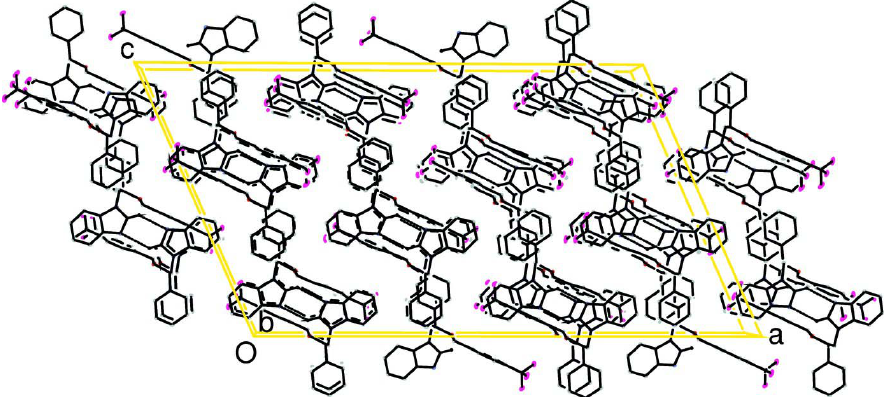
Figure 2 A packing diagram of the title compound. Hydrogen bonds are shown as dashed